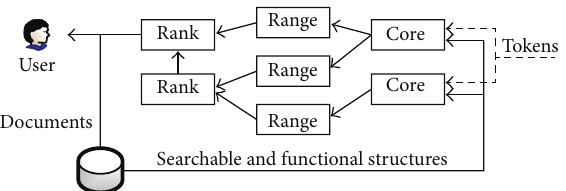
Figure 5: Deploying functional components to multiple servers.